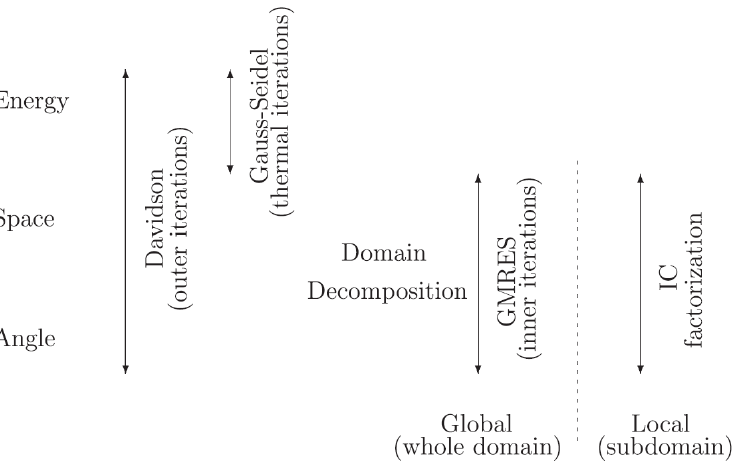
Figure 1. Parafish calculation